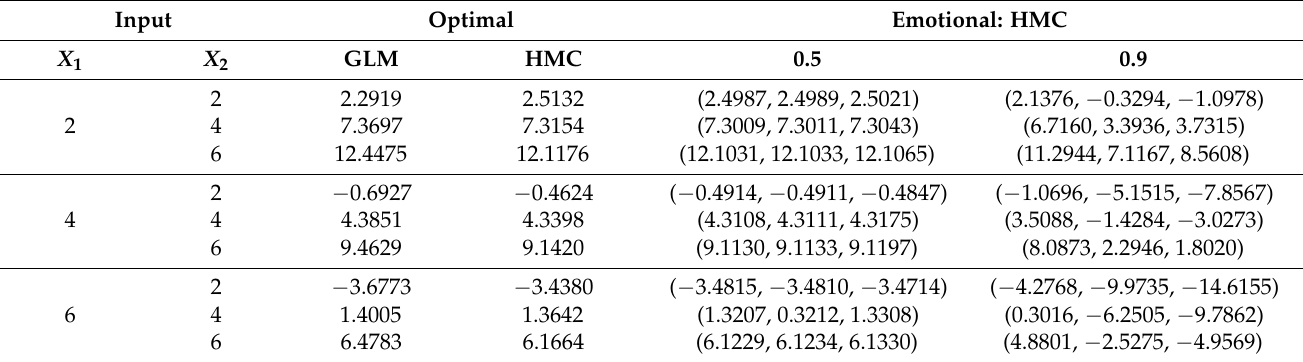
Table 4. Optimal and emotional decisions: simulation data.